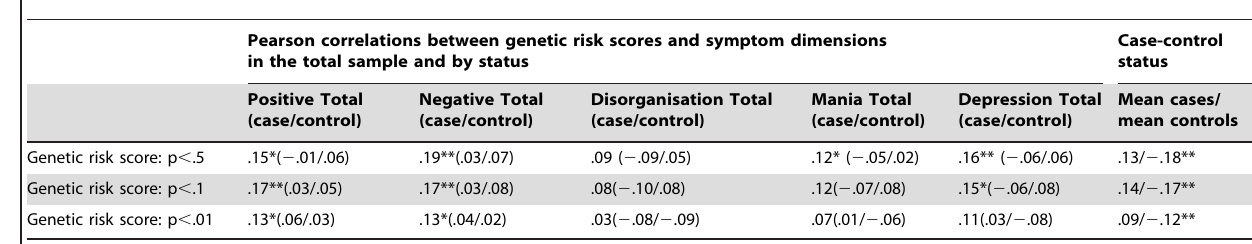
Table 1. Association of genetic risk scores with symptom dimensions and case-control status across thresholds.